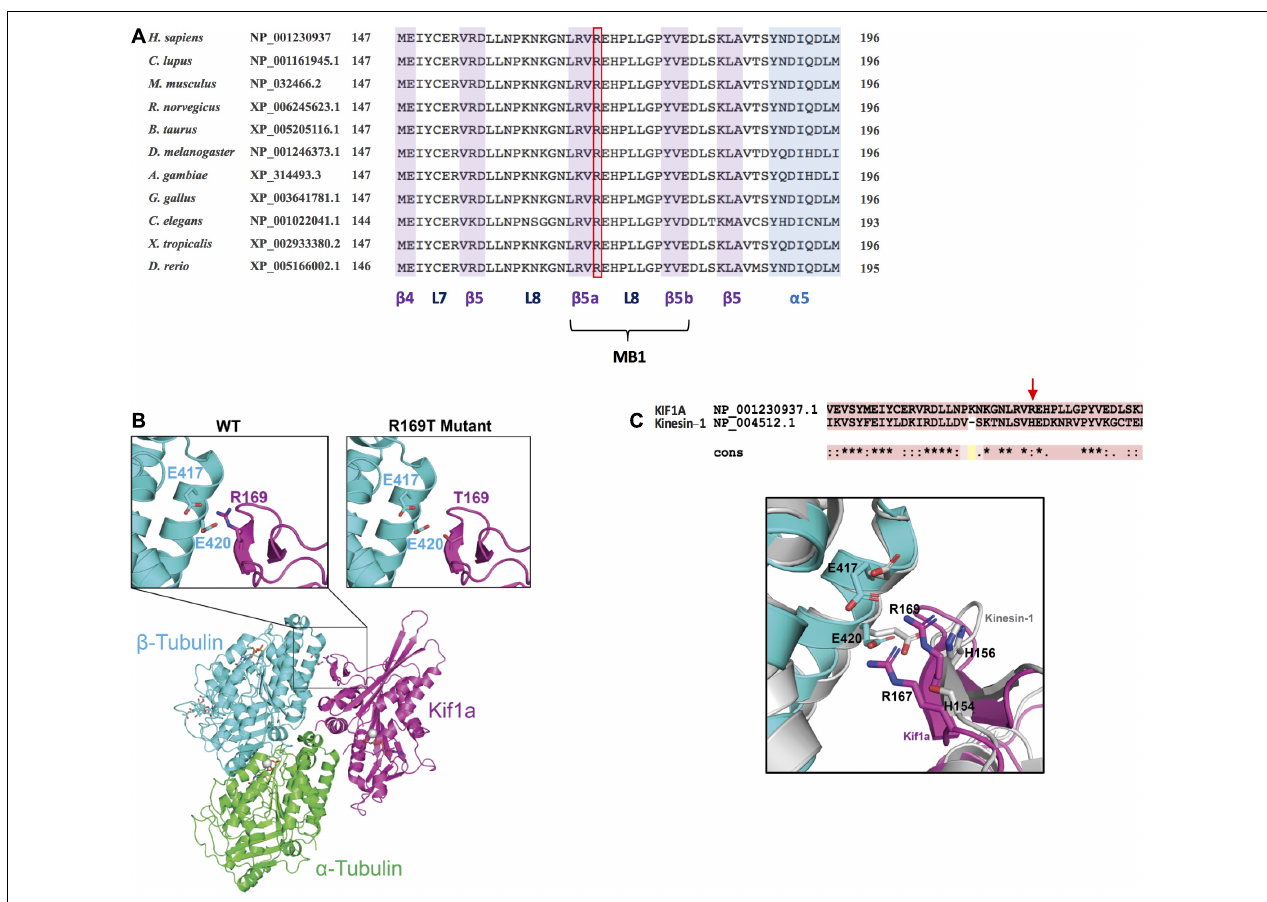
FIGURE 3 | Conservation analysis and structural modeling of the R169T variant. (A) Multiple-sequence alignment showing the conservation of R169 residue in KIF1A across evolution. The alignment has been performed using HomoloGene (https://www.ncbi.nlm.nih.gov/homologene). L7, loop 7; L8, loop 8; MB1, microtubule-binding region 1. (B) Schematic representation of KIF1A bound to the alpha/beta tubular heterodimer. Insets show close-up views of (left) the electrostatic interaction mediated by KIF1A R169 with β -tubulin residues E417 and E420 and (right) the loss of electrostatic interaction caused by KIF1A R169T mutation. α -Tubulin is shown in green, β -tubulin in cyan, and KIF1A in pink. (C) Superposed structure of microtubule-bound Kinesin-1 (PDB: 3J8Y) onto microtubule-bound KIF1A (PDB: